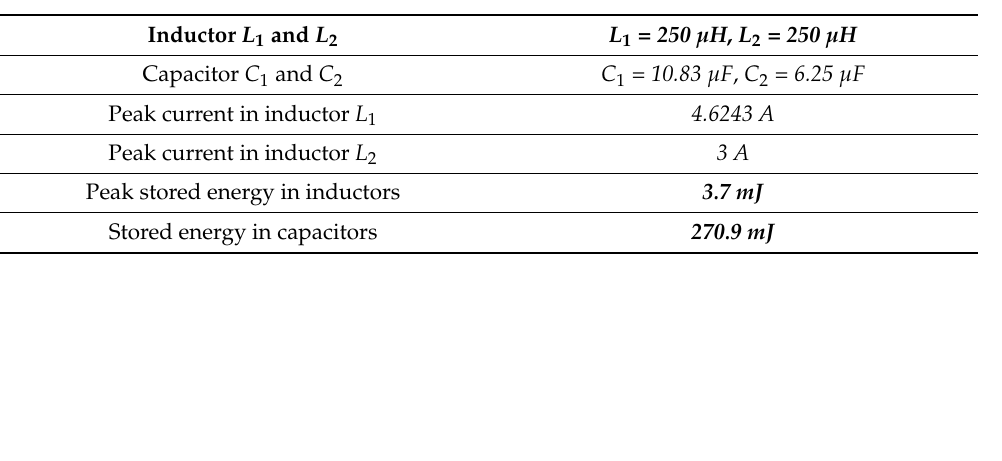
Figure 13. Result of the design with the proposed topology.